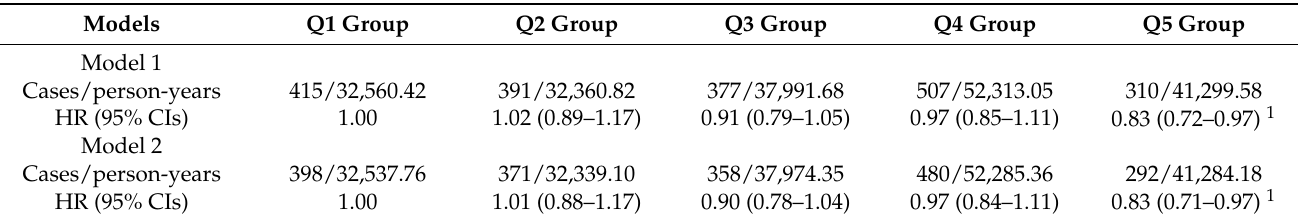
Figure 2. The association of DASH dietary groups with incident hyperuricemia. HR and 95% CIs were calculated with the use of the Cox proportional hazards regression model. 1 Minimally adjusted for baseline age and sex. 2 Fully adjusted for age, sex, marital status, education level, family history, BMI groups, hypertension, diabetes, hyperlipemia, smoking, alcohol drinking, PA, and total energy intake at baseline. Table 3. The association between DASH dietary groups with incident hyperuricemia 6 months and 12 months after baseline survey.